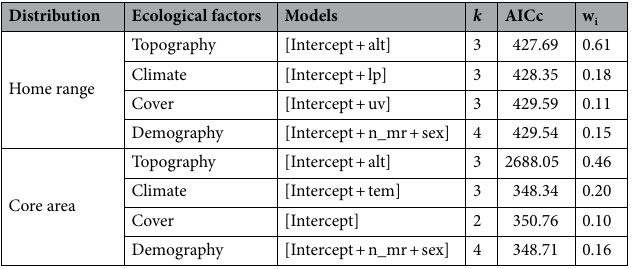
Table 1. Linear models that most accurately explained the effects of different ecological factors on the distribution of red-backed voles ( Myodes regulus ). alt, altitude; lp, lunar phase; tem, temperature; uv, understory vegetation; n_mr, number of Myodes regulus.